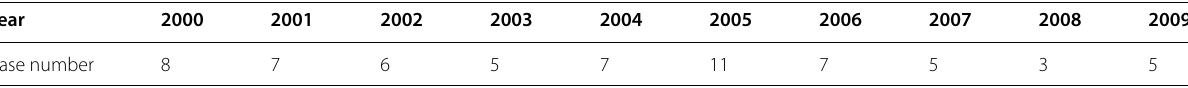
Table 2 The case number of TCs for QuickSCAT data in the WNP from 2000 to